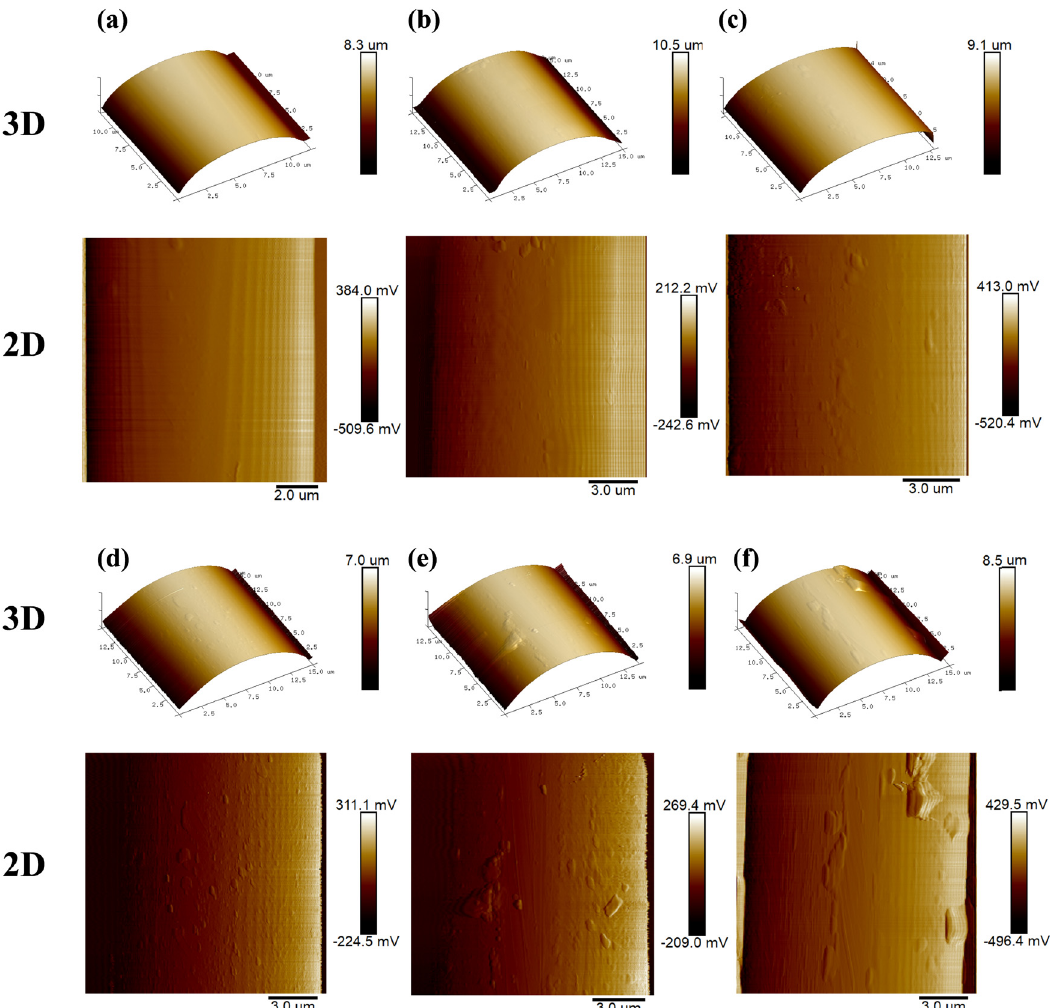
Figure 6: AFM micrograph of ( a ) U - BF, ( b ) C - BF, ( c ) K0.5 - BF, ( d ) K1.0 - BF, ( e ) K1.5 - BF, and ( f ) K2.0 - BF.